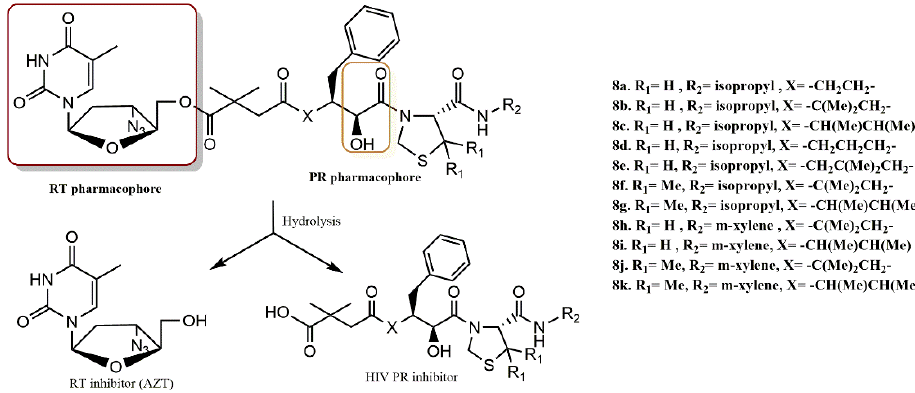
Figure 10. RT and PR pharmacophores of new active synthesized compounds 8a-k .